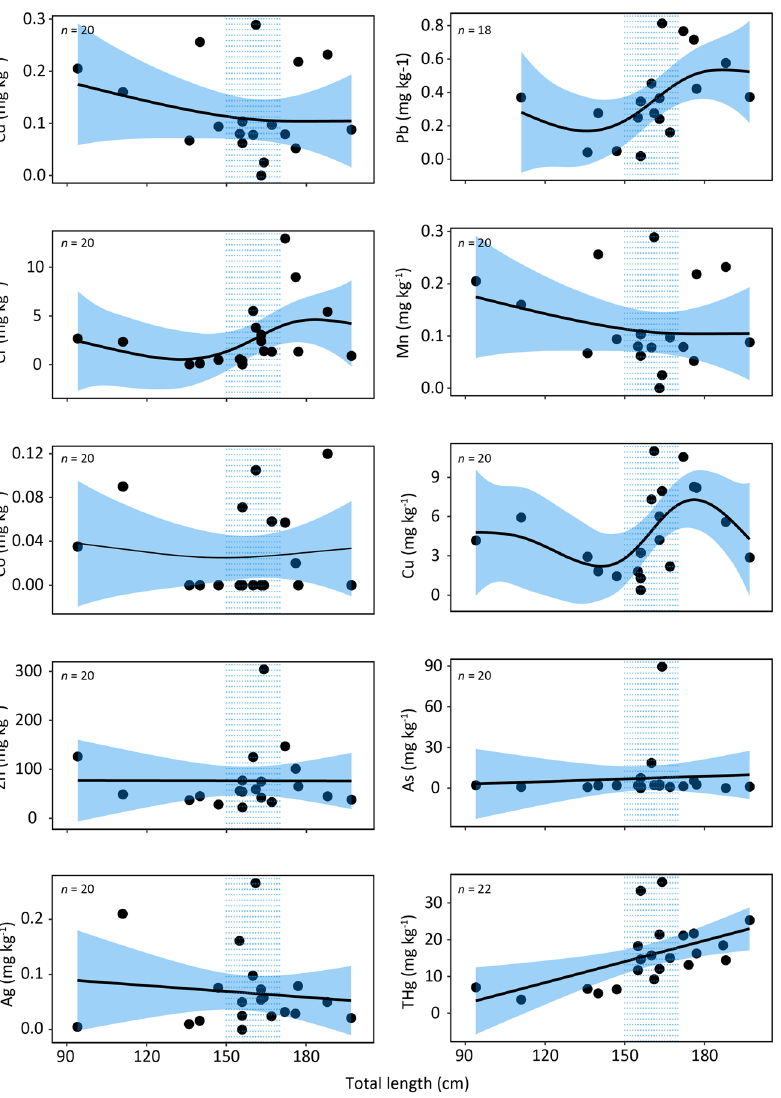
Figure 3. Generalized additive models (GAMs) fit for Caribbean Reef sharks investigating relationships between size and metal concentrations (mg kg −1 , dw). Blue shaded region represents standard error and blue dotted region represents range of published size-at-maturity estimates (152–168 cm 45 ; 150–170 cm, Pikitch et al. 46 ). Sample sizes differ between metals owing to removal of data that were potentially